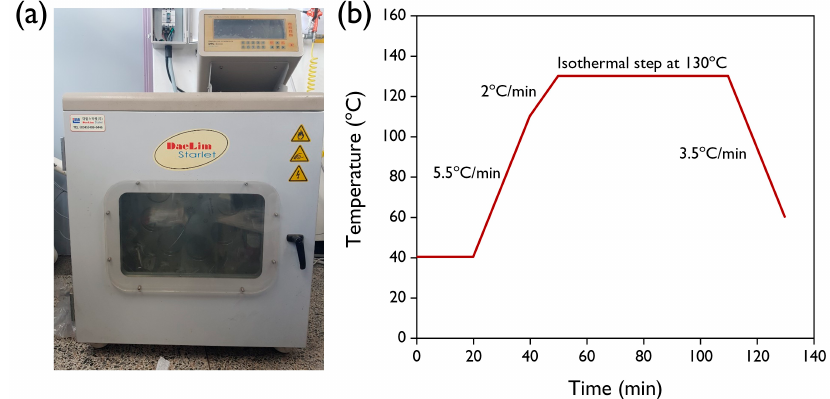
Figure 3. ( a )Theimageofthedyeingequipmentand( b Figure 3. ( a ) The image of the dyeing equipment and ( b ) the temperature profile of the basic dyeing condition.